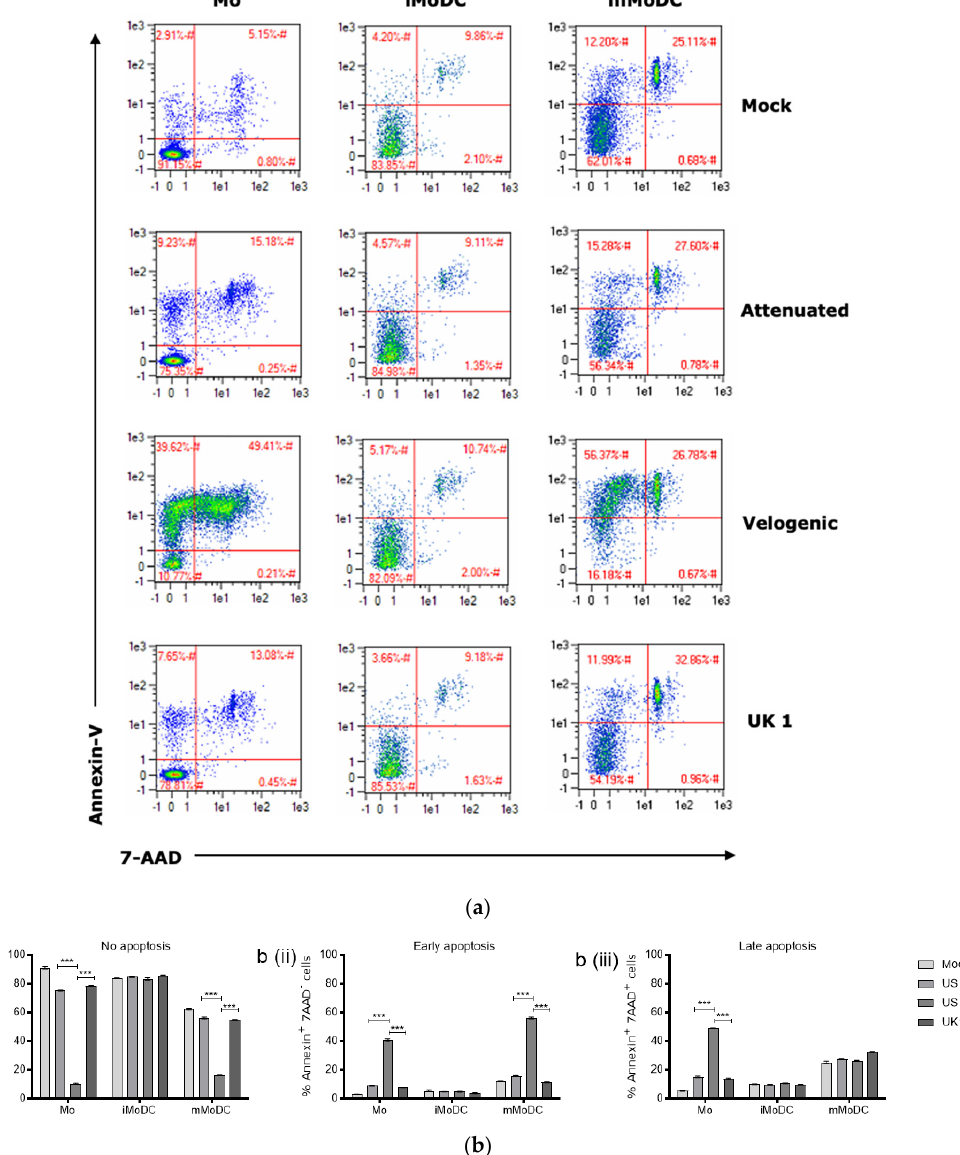
Figure 4. Apoptotic effect of EAV on Mo and MoDC. ( a ) Representative density plot of the apoptotic effect. The values in red represent the cell percentages in each gate. These plots are representative of nine independent repeats. ( b ) % Mo, immature (iMoDC) and mature MoDC (mMoDC) displaying no, early or late apoptosis. Mo, iMoDC and mMoDC were inoculated at MOI of 5 with different strains of live EAV. A mock control without virus was included. After 16 hpi cells were harvested and apoptosis assays performed by flow cytometry. Cells were stained with the apoptotic marker Annexin-V-FITC and live-dead stain 7-AAD-PE-Cy5 for 15 min at room temperature. Stained cells of the different treatments were analyzed by comparing the same number of events (10,000) in the monocyte or DC gate. A large percentage of Mo and mMoDC infected with the Velogenic strain were in the early apoptosis phase, Annexin-V + /7-AAD − ( a , bii ). Mo infected with the velogenic strain displayed the highest proportion of cells in late apoptosis phase. Annexin-V + /7-AAD + ( a , biii ). The viral apoptotic effect on iMoDC was minimal with most cells maintaining viability (Annexin-V − /7- AAD − ) compared to Mo and mMoDC ( a , b ). Data in ( b ) are represented as the mean percentage apoptotic cells ± SEM ( n = 4). Statistical significance was determined using a 2-way ANOVA with Bonferroni posttest to compare replicate means. *** indicate significant differences between sample means where p <